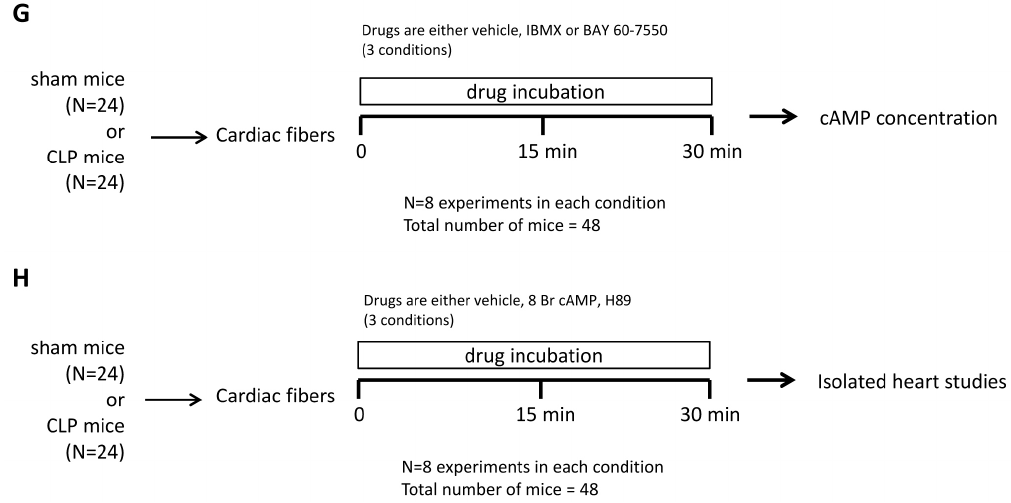
Figure 8. Total number of mice is displayed in ( A ). We first evaluated in vitro effects of